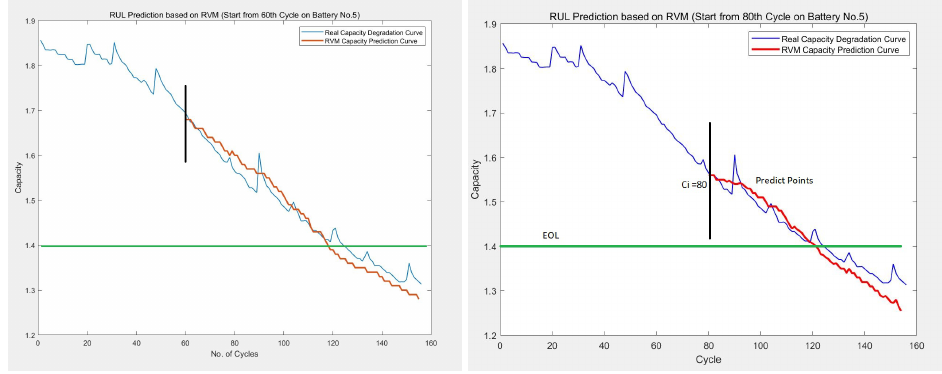
Figure 4. RUL loss curve for battery No.